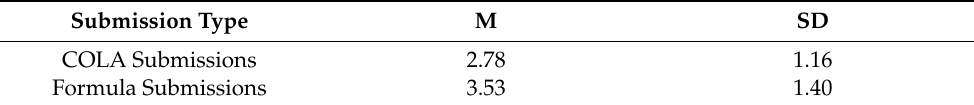
Table 8. Mean Volume of Resources Used During Label and Formula Submission Preparation.